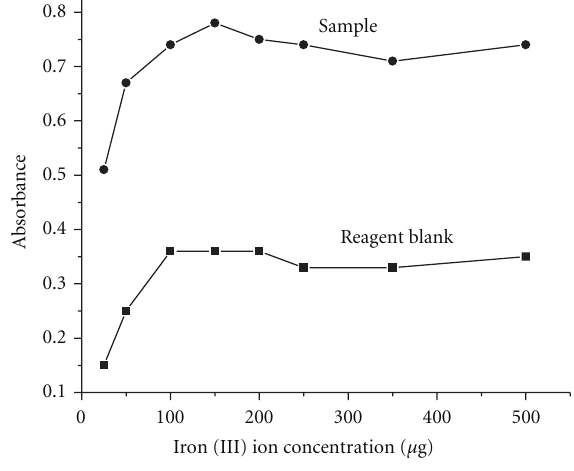
Figure 3: E ff ect of iron (III) ion.